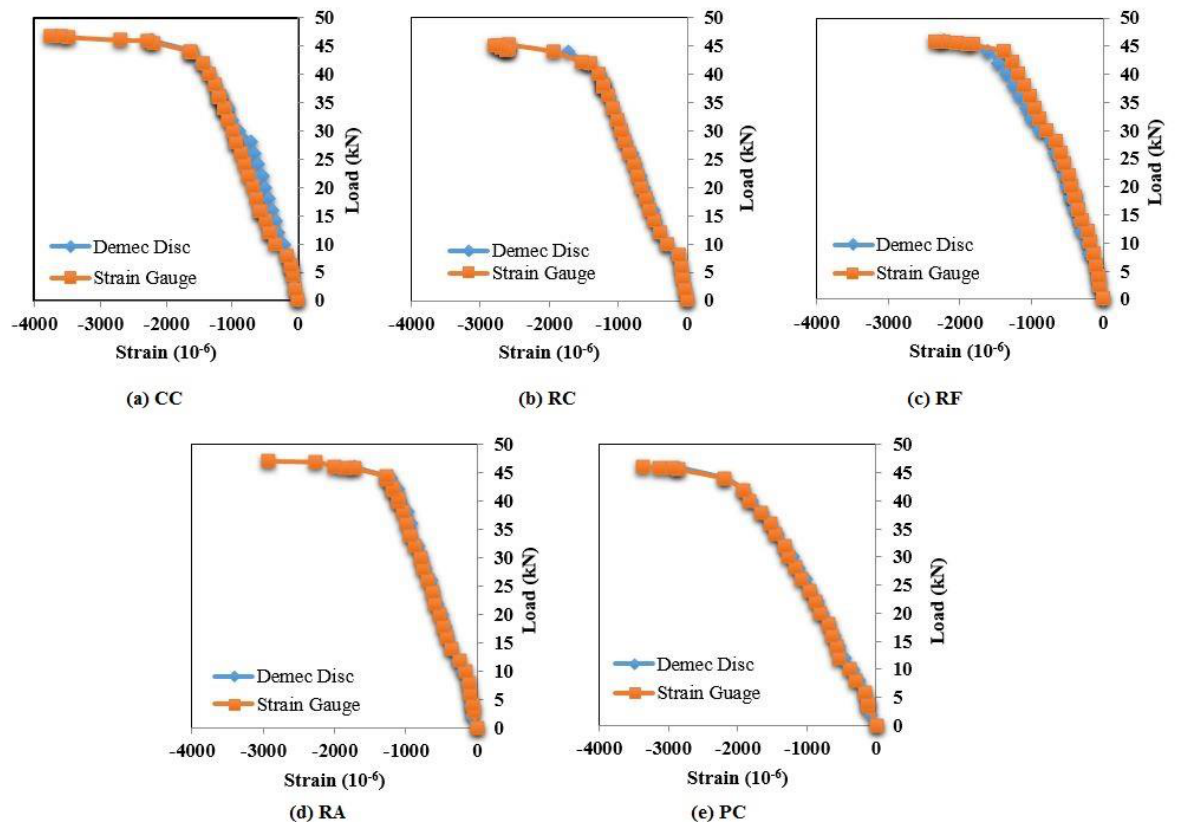
Figure 8. Load–strain behavior of the beams in the compression region ( a ) CC ( b ) RC ( c ) RF ( d ) RA ( e ) PC.